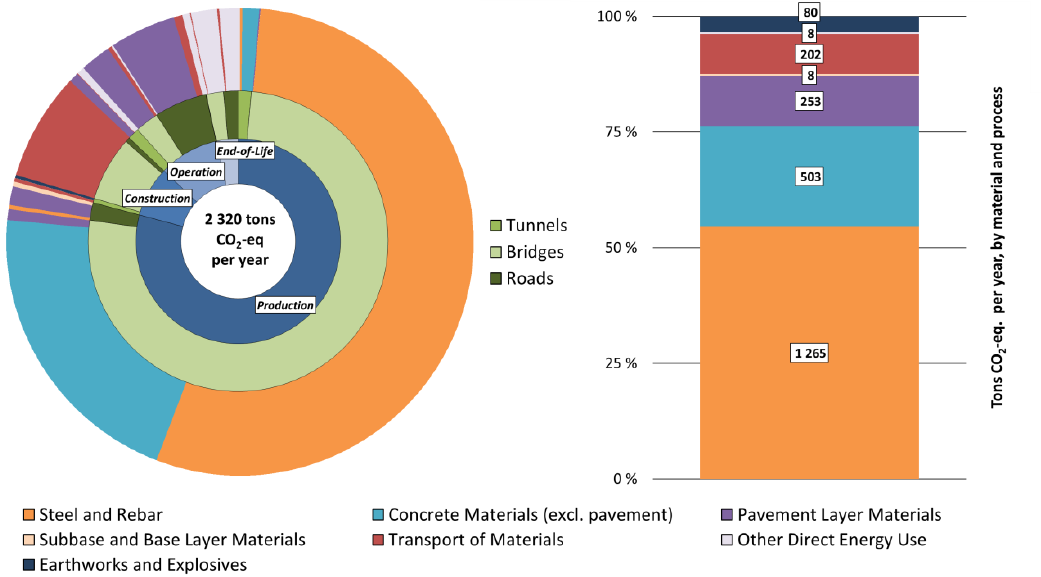
Figure 7. Contribution analysis for greenhouse gas (GHG) for Alternative